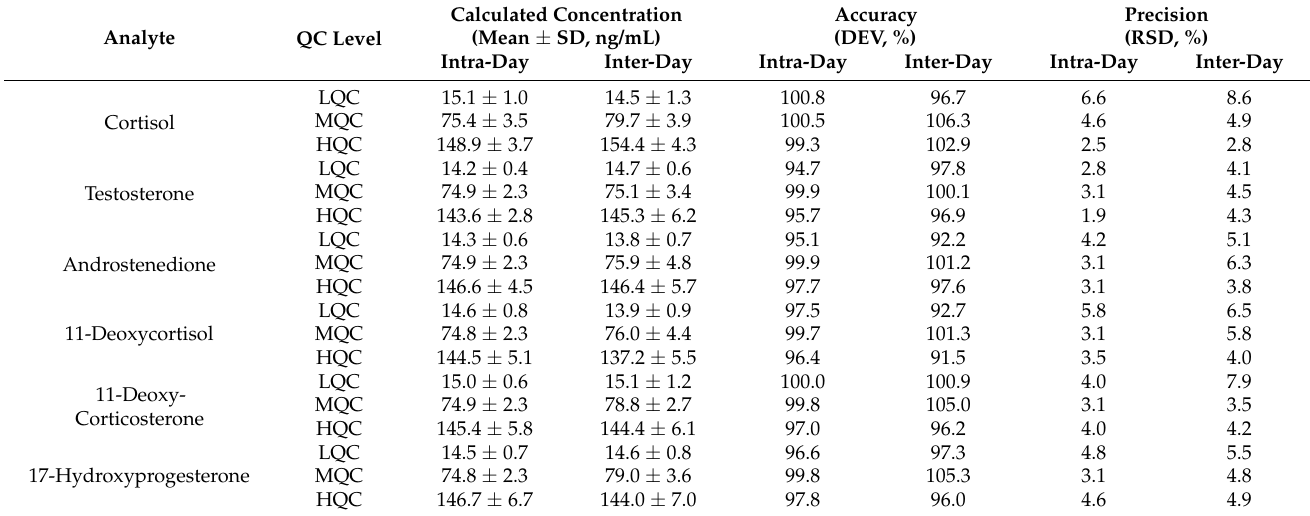
Table 3. Intra-day and inter-day accuracy and precision of the LC–MS method (n = 5).